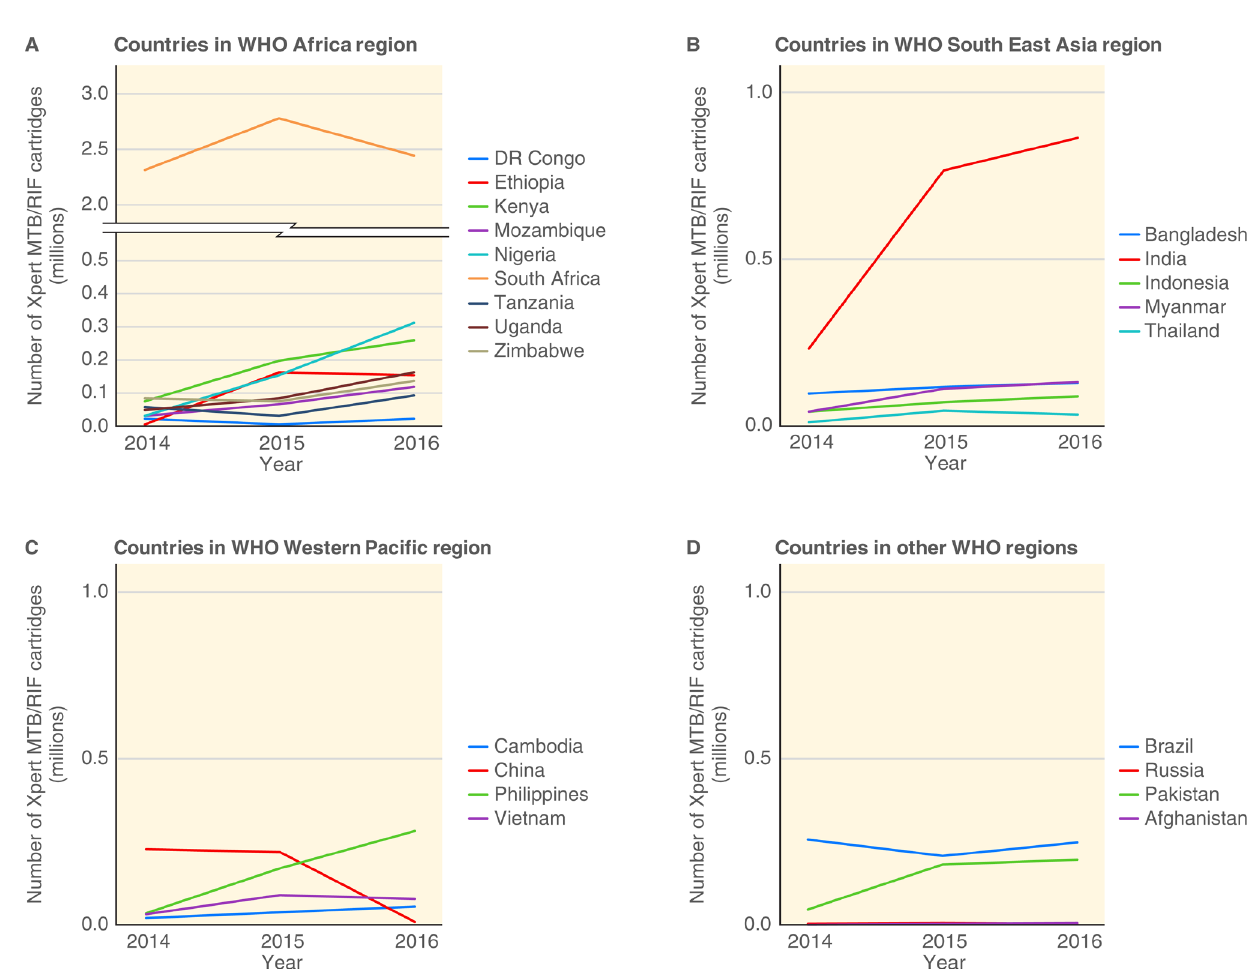
Figure 3. Xpert MTB/RIF cartridge procurement in World Health Organization (WHO) regions from